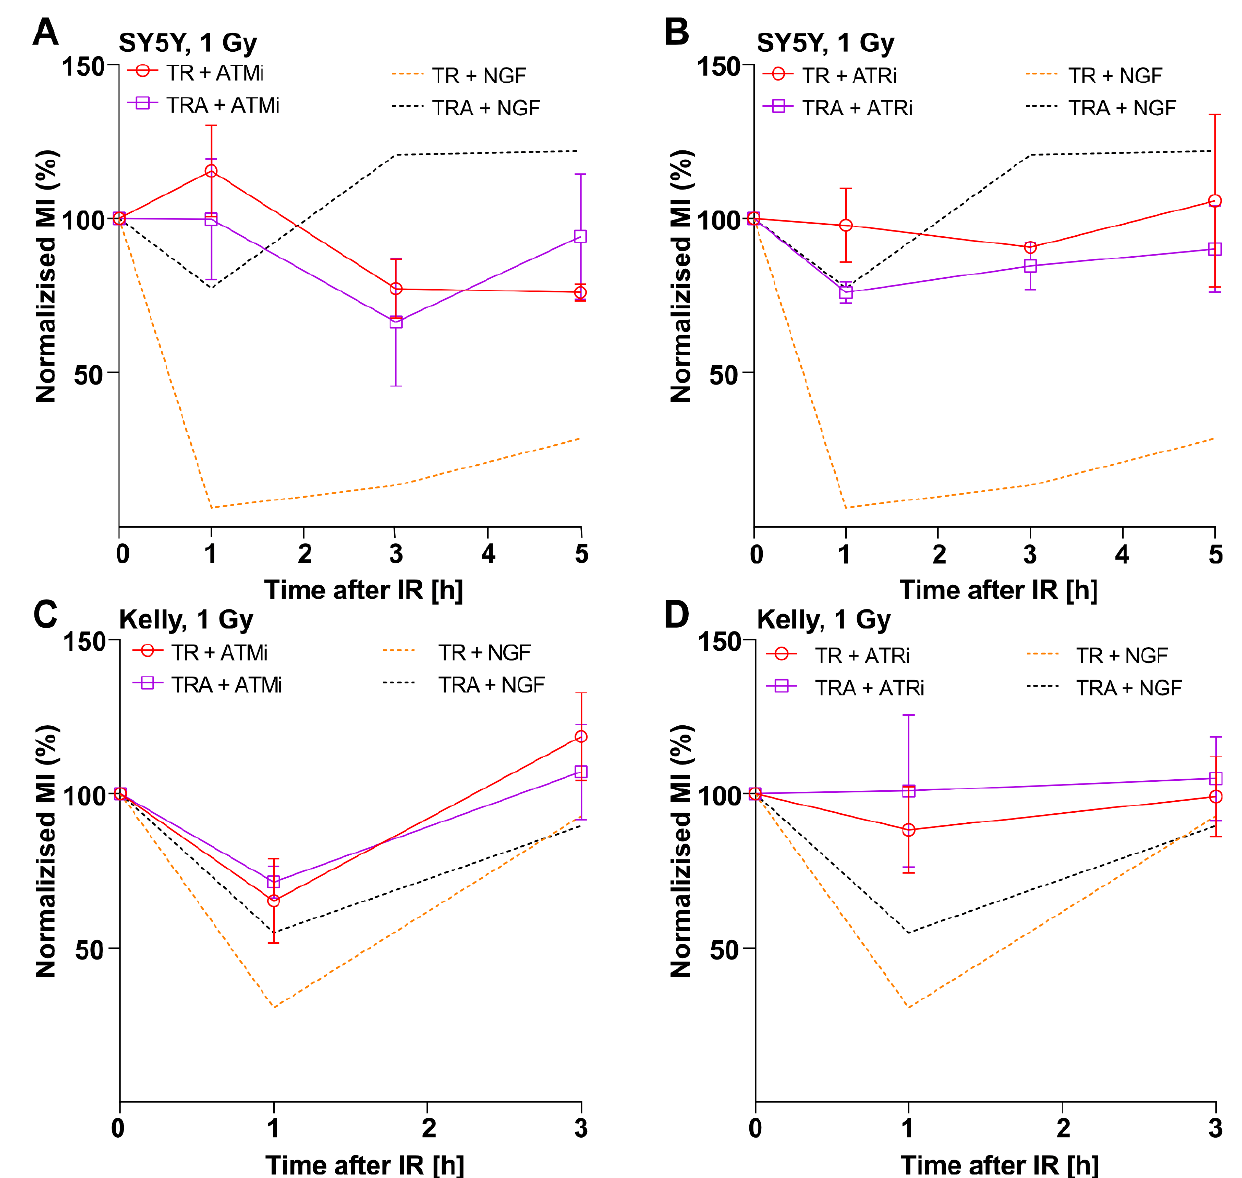
Figure 4. Inhibition of ATM- or ATR-signaling abrogates the G2 checkpoint upon IR. ( A , C ) SY5Y-TRA and Kelly-TRA cells with and without activation of TrkA/NTRK1 by NGF were exposed to an ATM inhibitor (ATMi, KU-55933) and irradiated with 1Gy. After irradiation, the mitotic indices (MI) were determined. ( B , D ) SY5Y-TRA and Kelly-TRA cells with and without activation of TrkA/NTRK1 by NGF were exposed to an ATR inhibitor (ATRi, VE821) and irradiated with 1Gy. After irradiation, the mitotic indices (MI) were determined. In all these experiments, cells containing the TET repressor only (SY5Y-TR, Kelly-TR) served as controls.